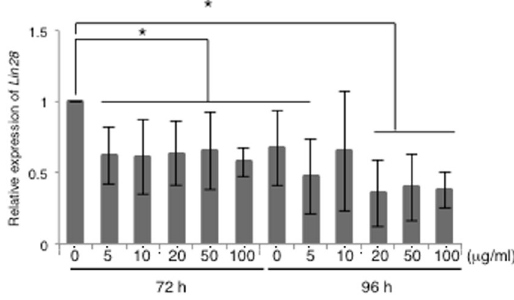
Figure 5. Effect of brentuximab vedotin on the expression of Lin28. Expression of Lin28 in hiPSC-derived CMs after brentuximab vedotin treatment was determined by qRT-PCR analysis. hiPSC-derived CMs were treated with brentuximab vedotin at the indicated doses for 72 and 96 h. Total RNA was isolated from the cells. Y-axis indicates relative gene expression compared with non-treated hiPSC-derived CMs for 72 h. Data were collected from at least three independent experiments. * p < 0.05 vs. 72 h, 0 μ g/ml.